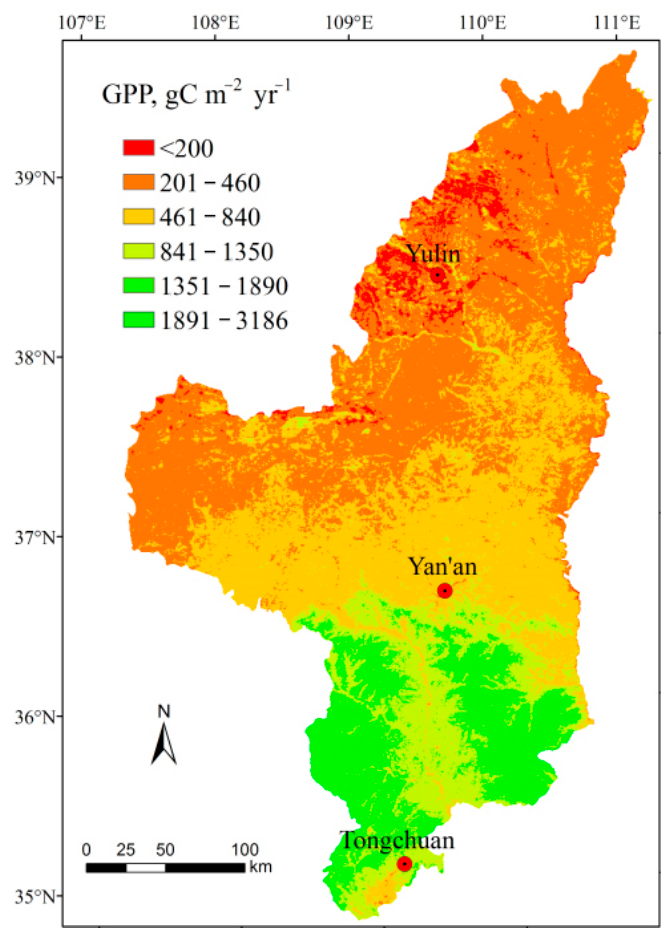
Figure 3. Spatial distribution of the mean GPP during 2000–2012 (g C m − 2 yr − 1 ).